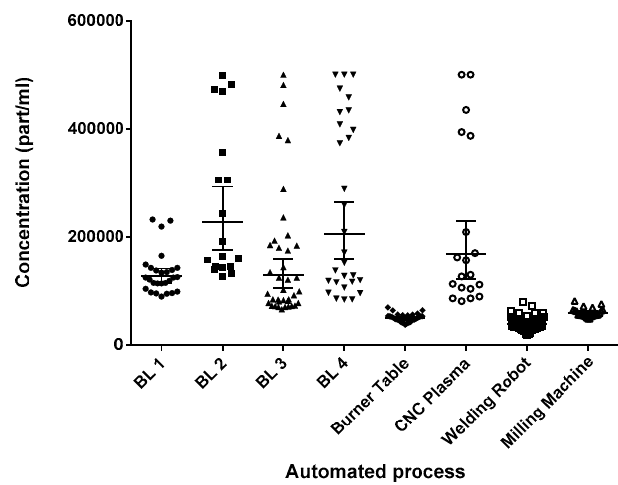
Figure 5. Distribution of machine source breathing zone grab samples; BL 1 ( n = 27), BL 2 ( n = 18), BL 3 ( n = 38), BL 4 ( n = 29), burner table ( n = 35), CNC plasma ( n = 19), welding robot ( n = 47), and milling machine ( n = 23). BL: beamline; CNC: computerized numerical